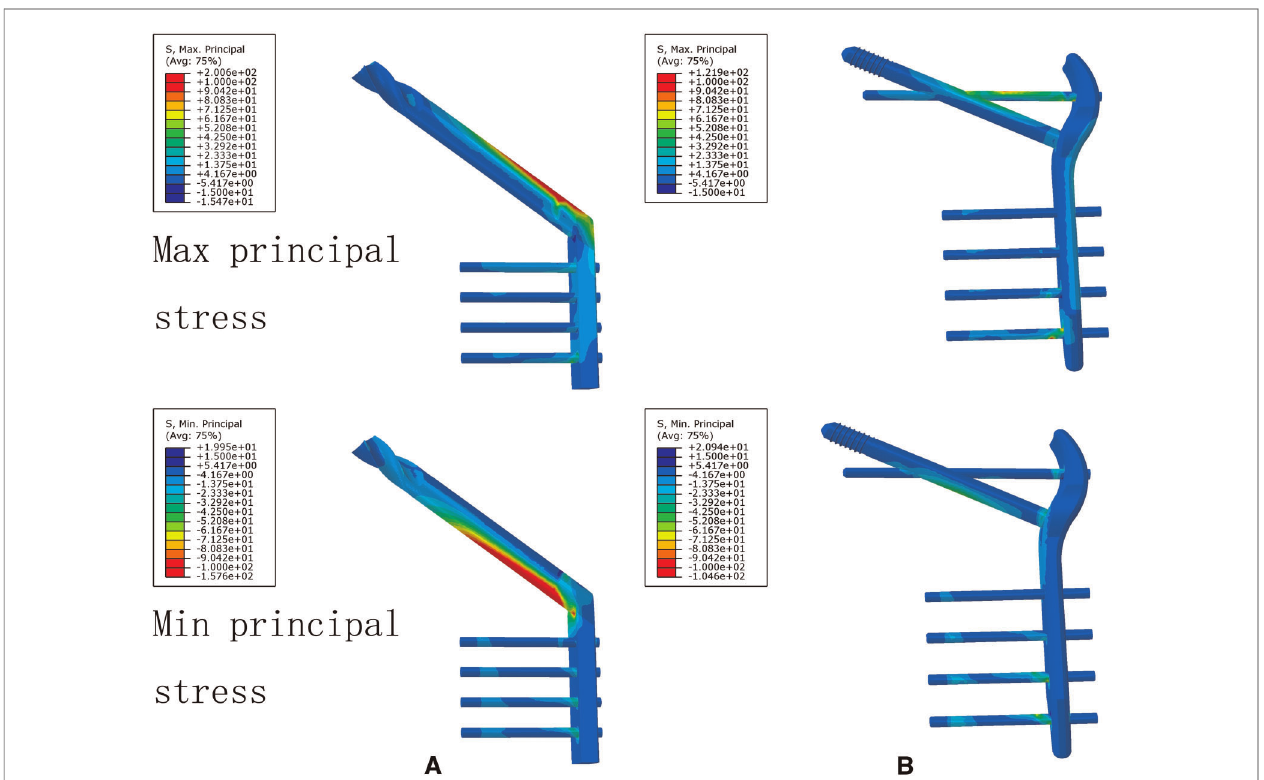
FIGURE 11 | The maximum principal stress and minimum principal stress extremes of two implant models for the treatment of an unstable intertrochanteric fracture. The fi gure shows that the TSFP has improved the maximum principal stress distribution compared with DHS for the fi xation of Evans type IV intertrochanteric fracture.